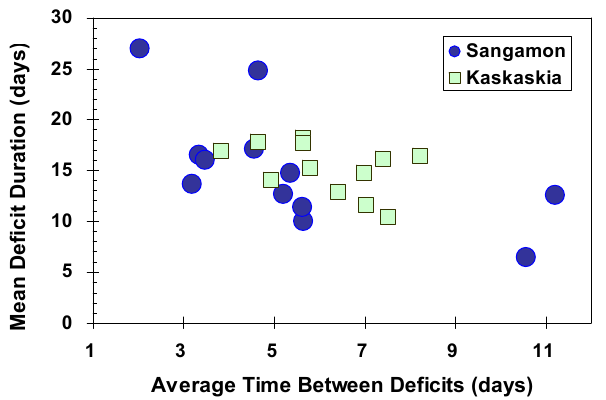
Fig. 13. Scaling of relative deficit with drainage